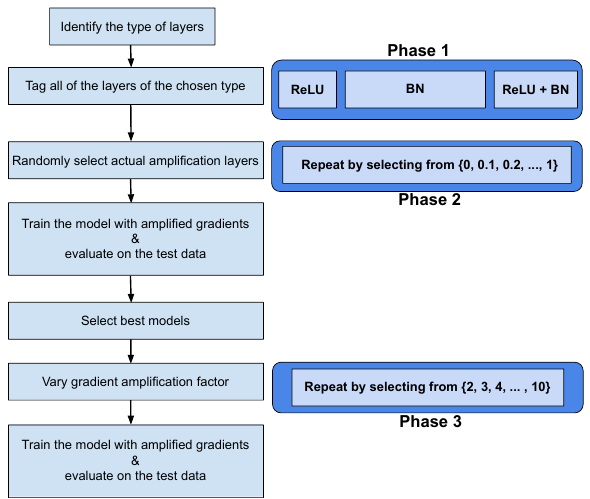
Fig. 3 Overview of all the experiments performed by varying different parameters of gradient